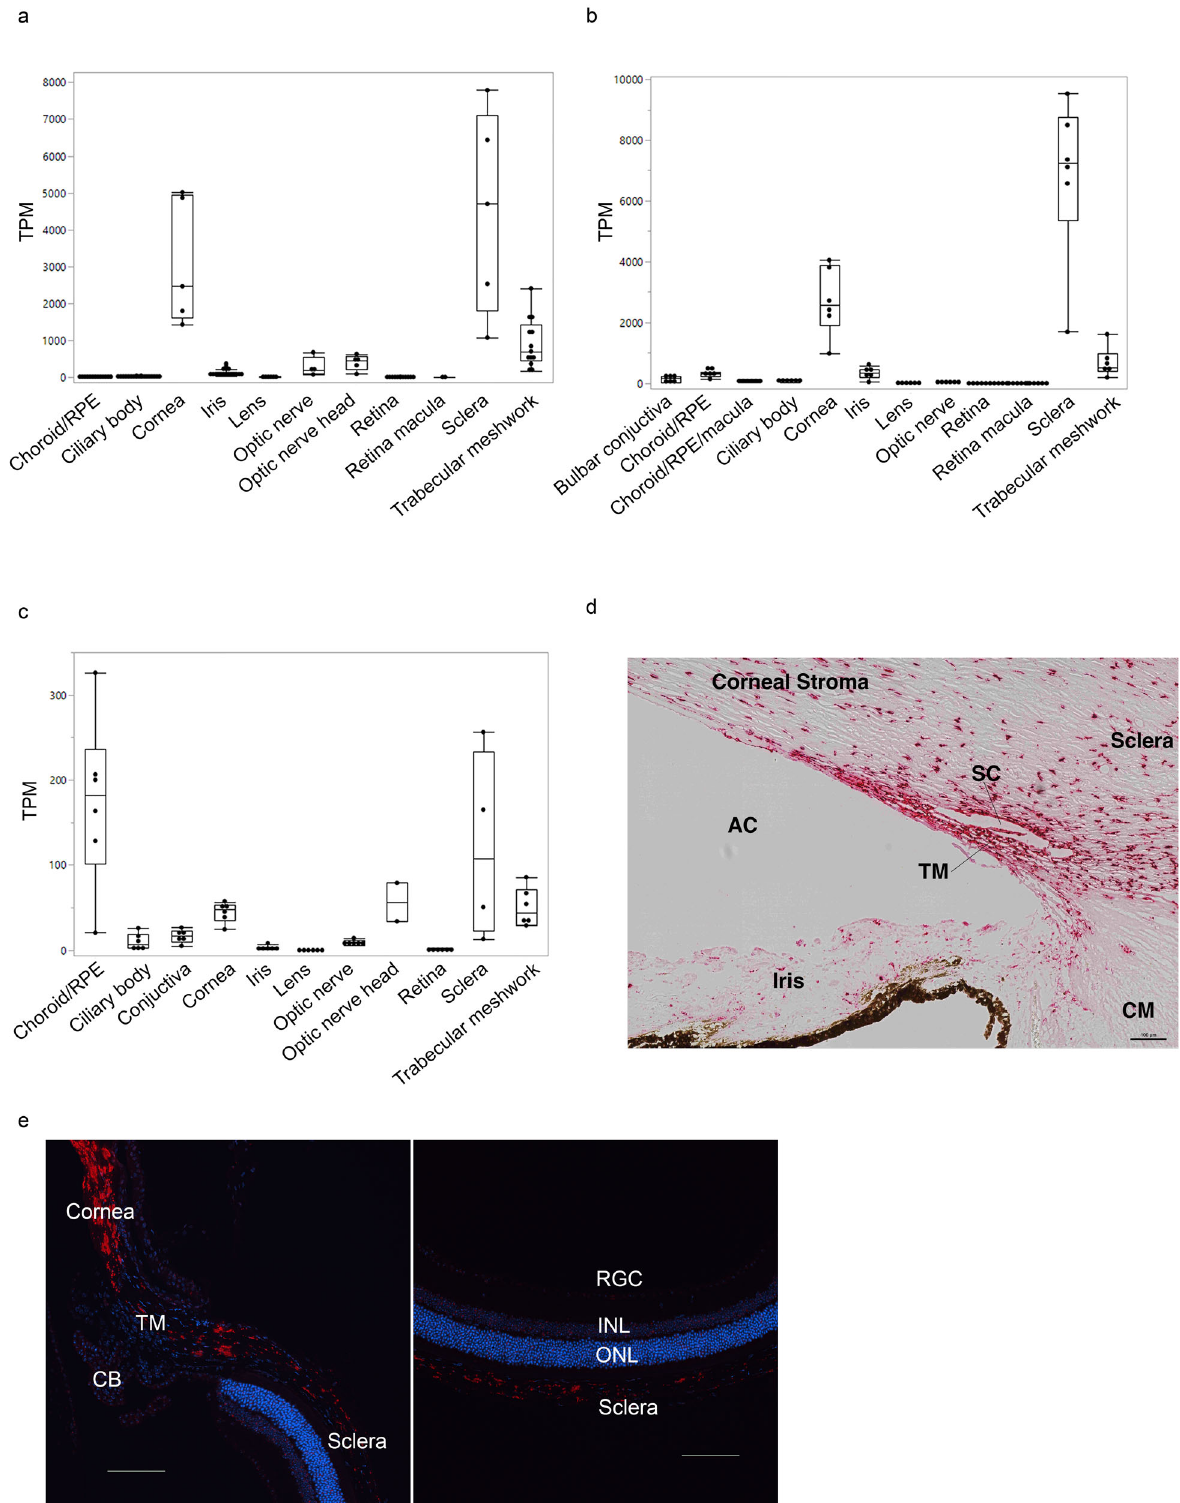
Fig. 5 ANGPTL7 expression in ocular tissues across species. RNA-sequencing-based expression levels (measured in transcripts per million, TPM, and represented as median and interquartile range) are highest in cornea, trabecular meshwork (TM), and sclera in human ( a ), and African green monkey ( b ) eyes, and in cornea, TM, sclera, optic nerve head, and choroid/RPE in C57BL/6 J mouse eyes ( c ); In situ hybridization (RNAscope) shows ANGPTL7 / Angptl7 (red) expression in TM, cornea and sclera in human ( d ) and murine ( e ) eyes. Scale bars represent 100 μ m. DAPI staining (blue) counterstains cell nuclei. RPE retinal pigmented epithelium, CB ciliary body, SC Schlemm ’ s canal, CM ciliary muscle, AC anterior chamber, RGC retinal ganglion cell, INL inner nuclear layer, ONL outer nuclear